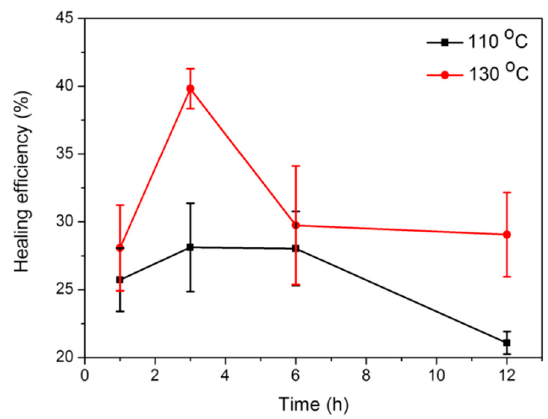
Figure 7. Self-healing efficiency of WPU-cystamine. Table 2. Tensile properties and self-healing efficiency of WPU-cystamine.